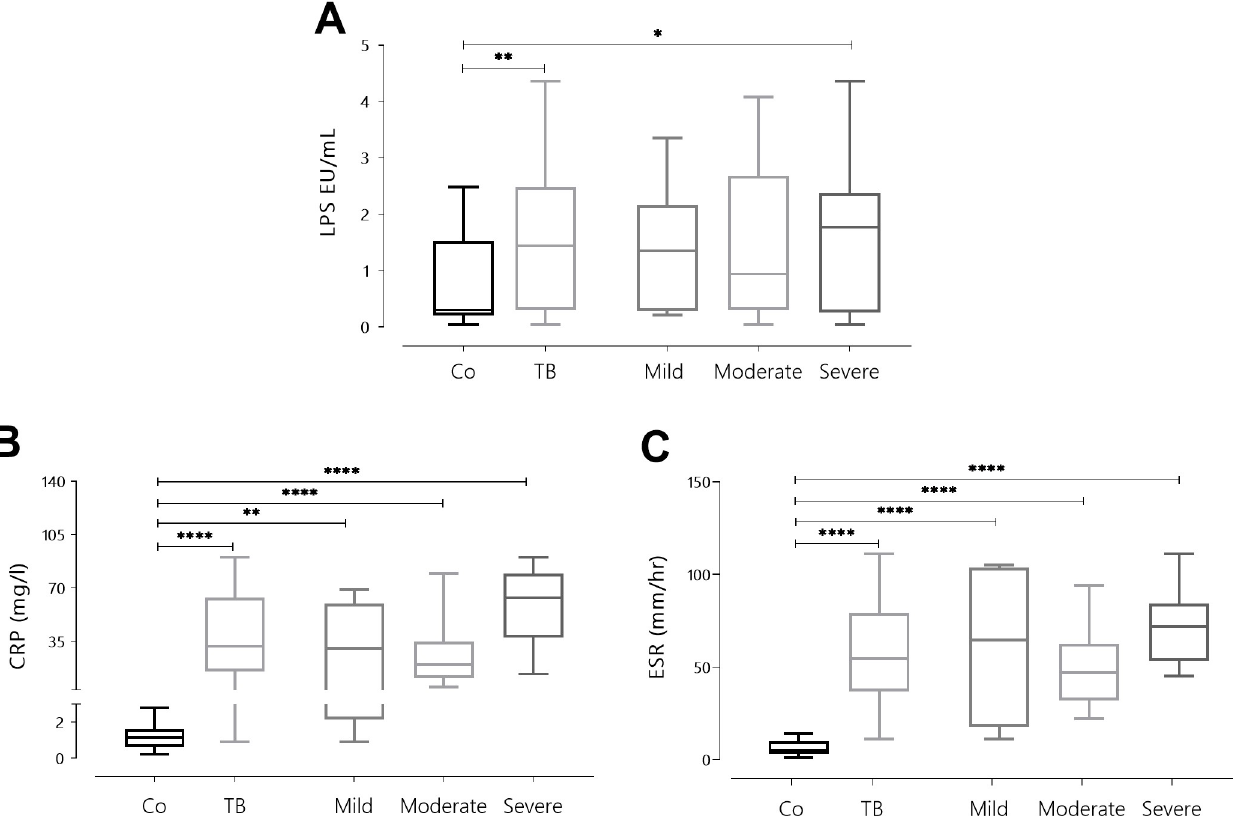
Fig 1. Plasma levels of Lipopolysaccharides (LPS) (A), C-reactive protein (CRP) (B) along with erythrocyte sedimentation rate (ESR) (C) in Co and TB patients. Box plots show median values, 25–75 percentiles from data in each group with maximum and minimum values. Statistically significant at � p < 0.05, �� p < 0.01, ��� p < 0.001, ���� p <